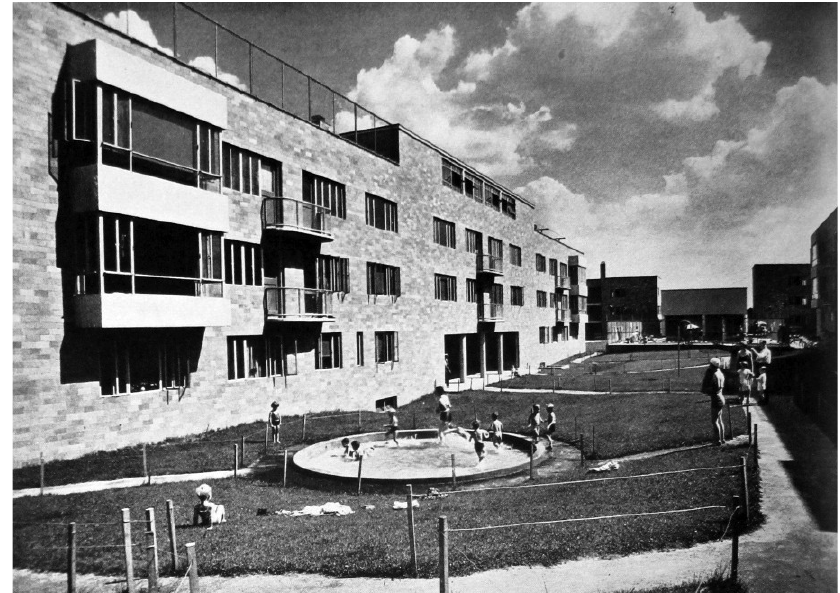
Figure 5. Carl Mackley Houses, Juniata Park, Philadelphia (1931–1933). Source: “ A tale of two cities” (1938).